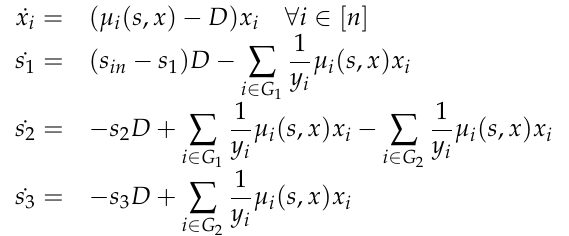
Table 1. Relationship of y s